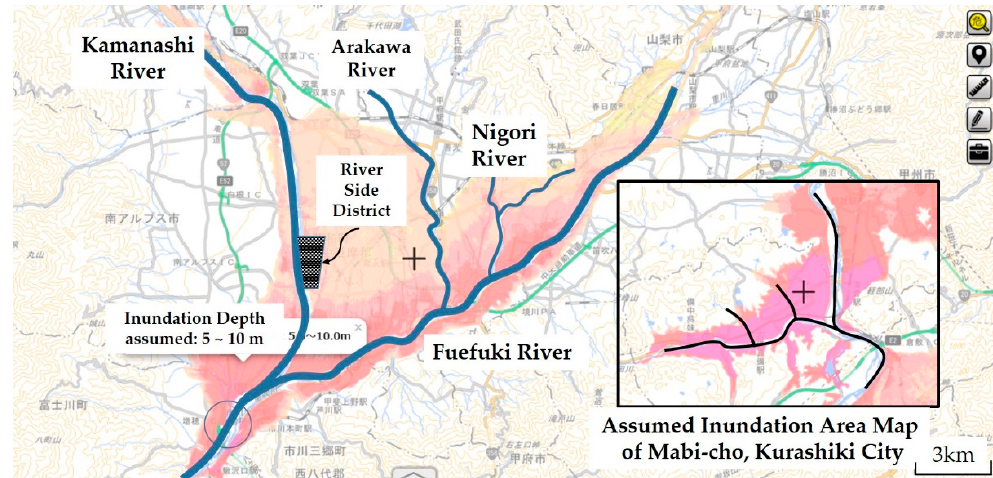
Figure 3. Assumed inundation map of the Kofu Basin compared with that of Mabi-cho.